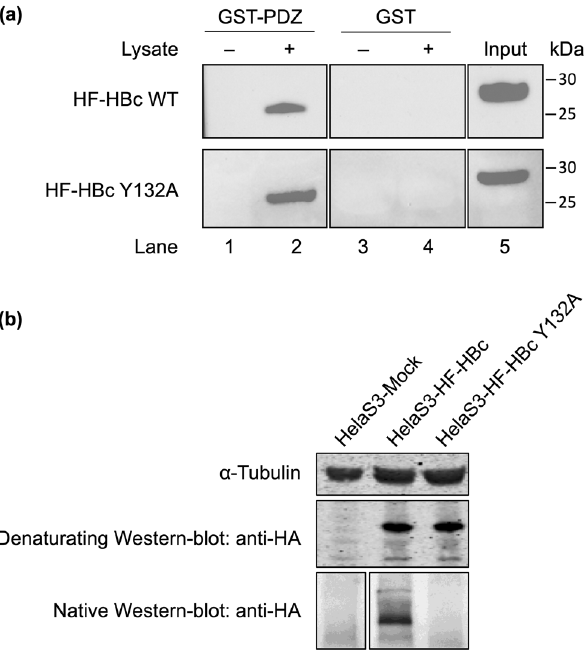
Figure 3. GST pull-down assay of GST-tagged PTPN3 PDZ domain against HeLa S3 cell lysate overexpressing HBc. ( a ) GST (negative control) and GST fusion proteins were bound to the same amount of glutathione- agarose beads and allowed to interact with HF-tagged HBc protein from lysates of HeLa S3 cells overexpressing either the HF-tagged full-length WT HBc or the Y132A mutant. Samples were washed and analyzed by Western blot with anti-HA antibodies. (upper part) Lanes 1 and 2: GST-PTPN3-PDZ in absence or presence of lysate containing HF-HBc WT, respectively; Lanes 3 and 4: GST in absence or presence of lysate containing HF-HBc WT respectively; Lane 5 shows the signal of HF-HBc WT in lysates of HeLa S3 cell lysate . (lower part) Lanes 1 and 2: GST-PTPN3-PDZ in absence or presence of lysate containing HF-HBc Y132A, respectively; Lanes 3 and 4: GST in absence or presence of lysate containing HF-HBc Y132A respectively; Lane 5 shows the signal of HF–HBc Y132A in lysates of HeLa S3 cell lysate. (right) Ticks and labels indicate molecular weight markers. ( b ) Native Western blot on the HeLa S3 HF-HBc WT and HF-HBc Y132A using the anti-HA antibody. Note that blots represent discontiguous panels from the gels when black line delimitation is present. The images have been cropped to frame the relevant region for